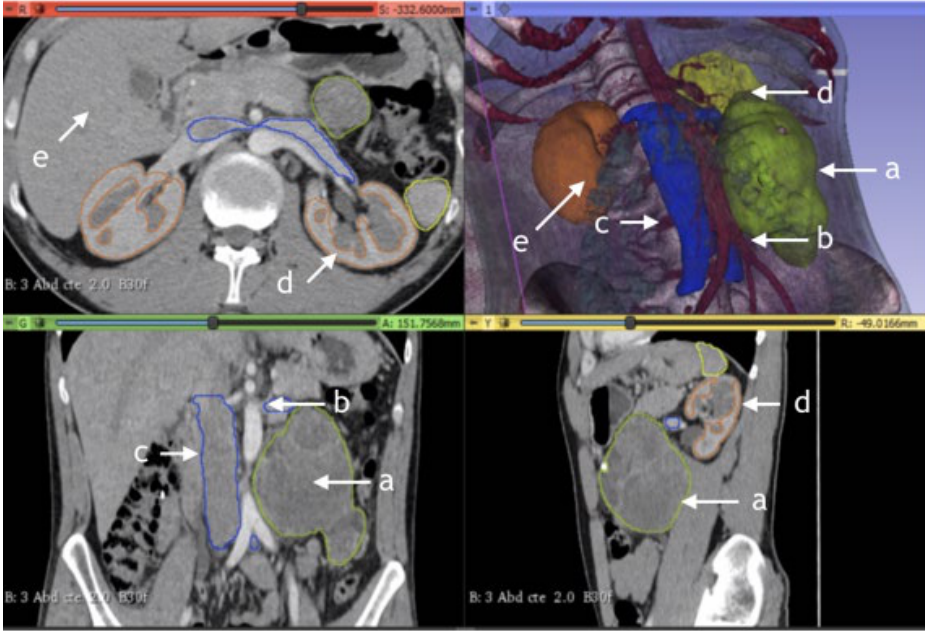
Figure 4. Para-aortic residual mass, post-chemotherapy germ cell tumor. Example of CT-rendered 3D reconstruction: (a) tumor; (b) aorta; (c) v. cava; (d) kidney; and (e) spleen.